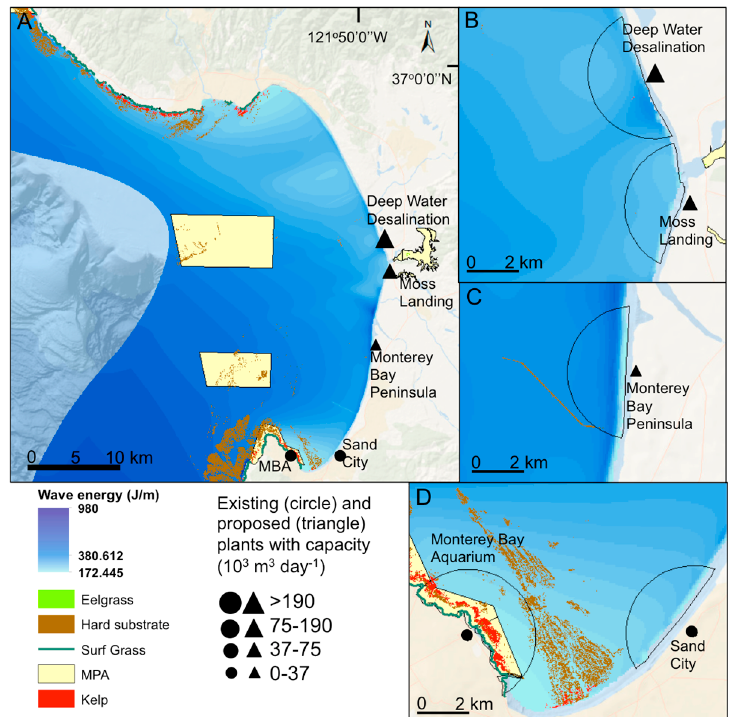
Figure 7. Average wave energy and benthic habitat for Monterey Bay with existing (circles) and proposed (triangles) desalination facilities ( A ). Zoomed perspective is shown in B – D .